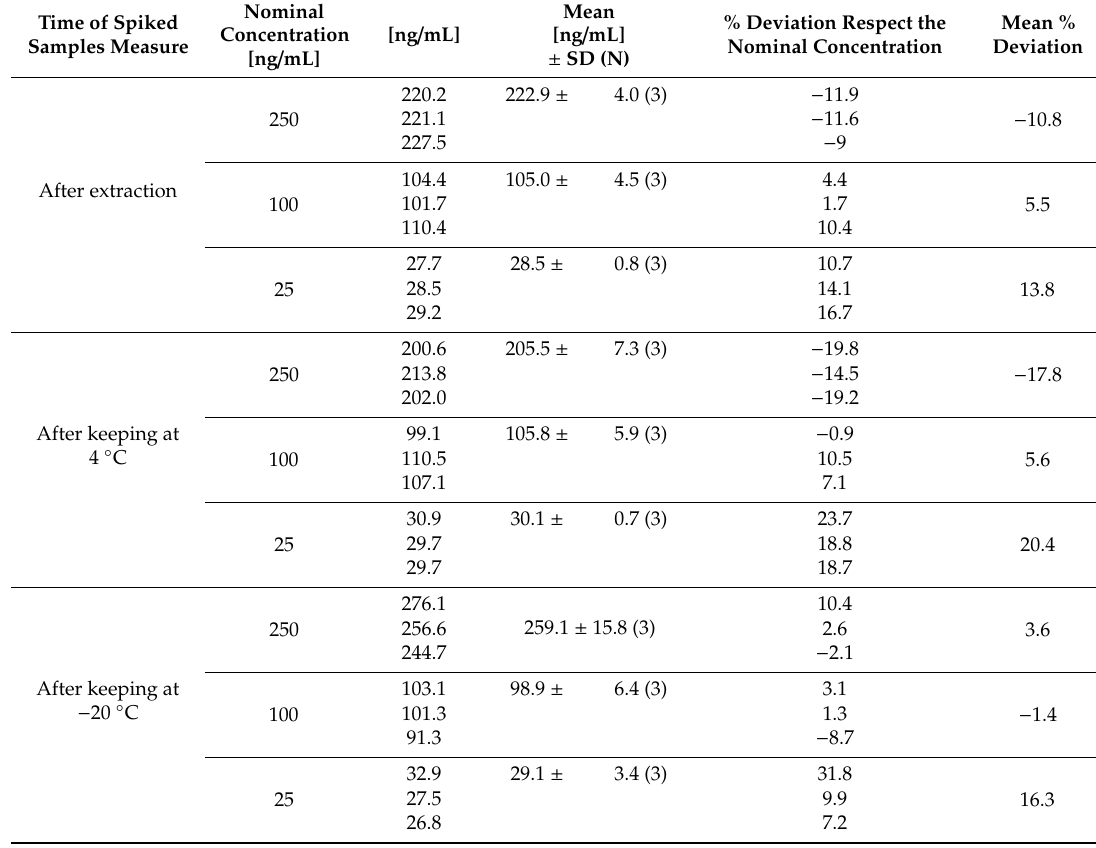
Table 3. The results of three di ff erent measures of spiked